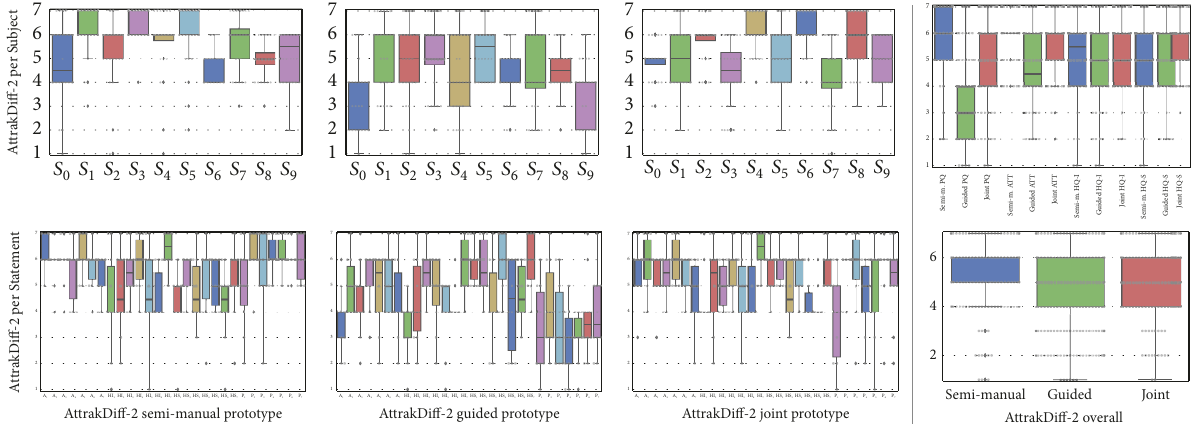
AttrakDiff-2 overallAttrakDiff-2 joint prototypeAttrakDiff-2 guided prototype